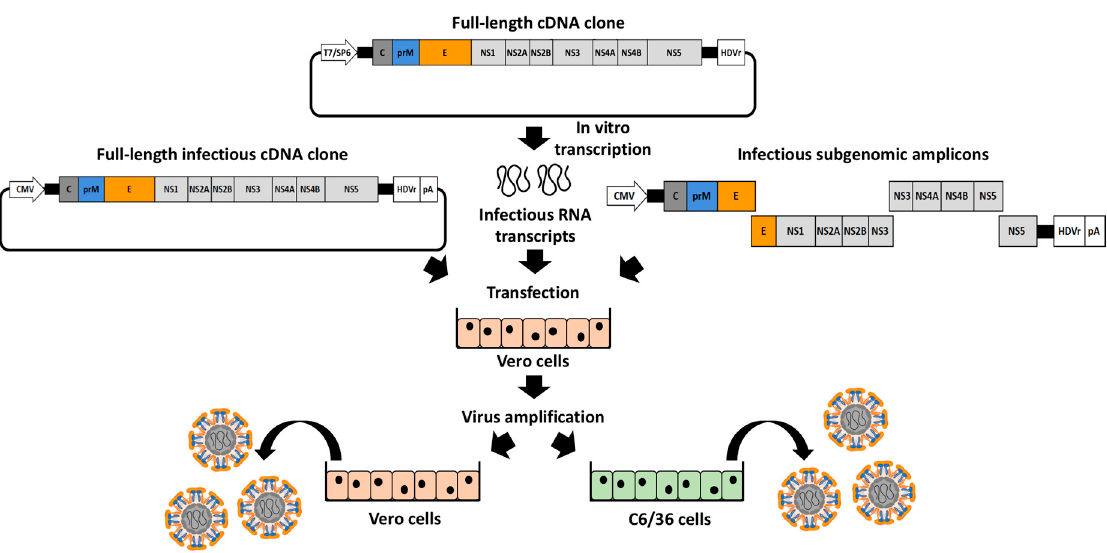
Figure 3. Schematic representation for the generation of rZIKV: Mammalian Vero cells are transiently transfected with infectious RNA transcribed in vitro from a full-length cDNA clone (top), full-length infectious cDNA clones ( left ) or infectious subgenomic amplicons ( right ) (see also Figure 2). After 3–4 days post-transfection, when cytopathic effect is observed, rZIKVs present in tissue-culture supernatants can be recover for titration or viral amplification in mammalian (Vero, left ) or insect (C6/36, right ) cells.